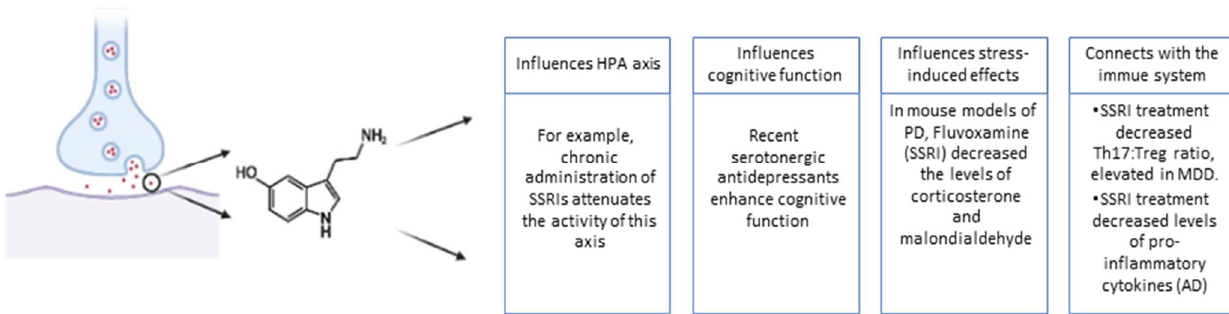
Figure 1. Examples of processes such as increased levels of the amyloid precursor protein, loss of nigral neurons, and decrease in the activation of 5-HT1A receptors are implicated as results of immune and stress dysregulation, worsening neurological diseases such as MDD, AD and PD. Created with BioRender.com.